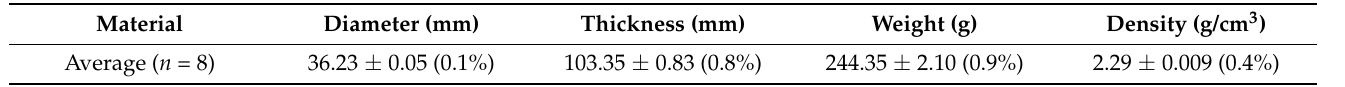
Table 7. Main physical results of tested C-RB samples.